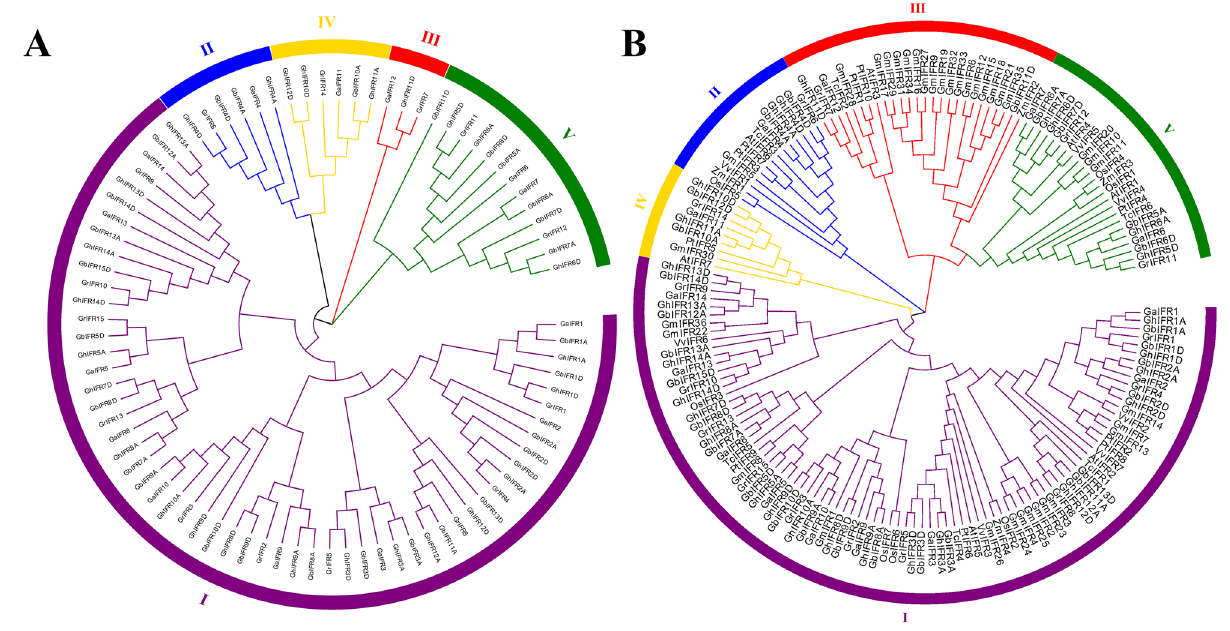
Figure 1. Phylogenetic trees of four Gossypium species and other 7 species. ( A ) Phylogenetic trees of the IFR genes from four Gossypium species, ( B ) Phylogenetic relationship of the IFR genes from four Gossypium species and other 7 species. The 5 clades, designated as I to V, are marked with different colored